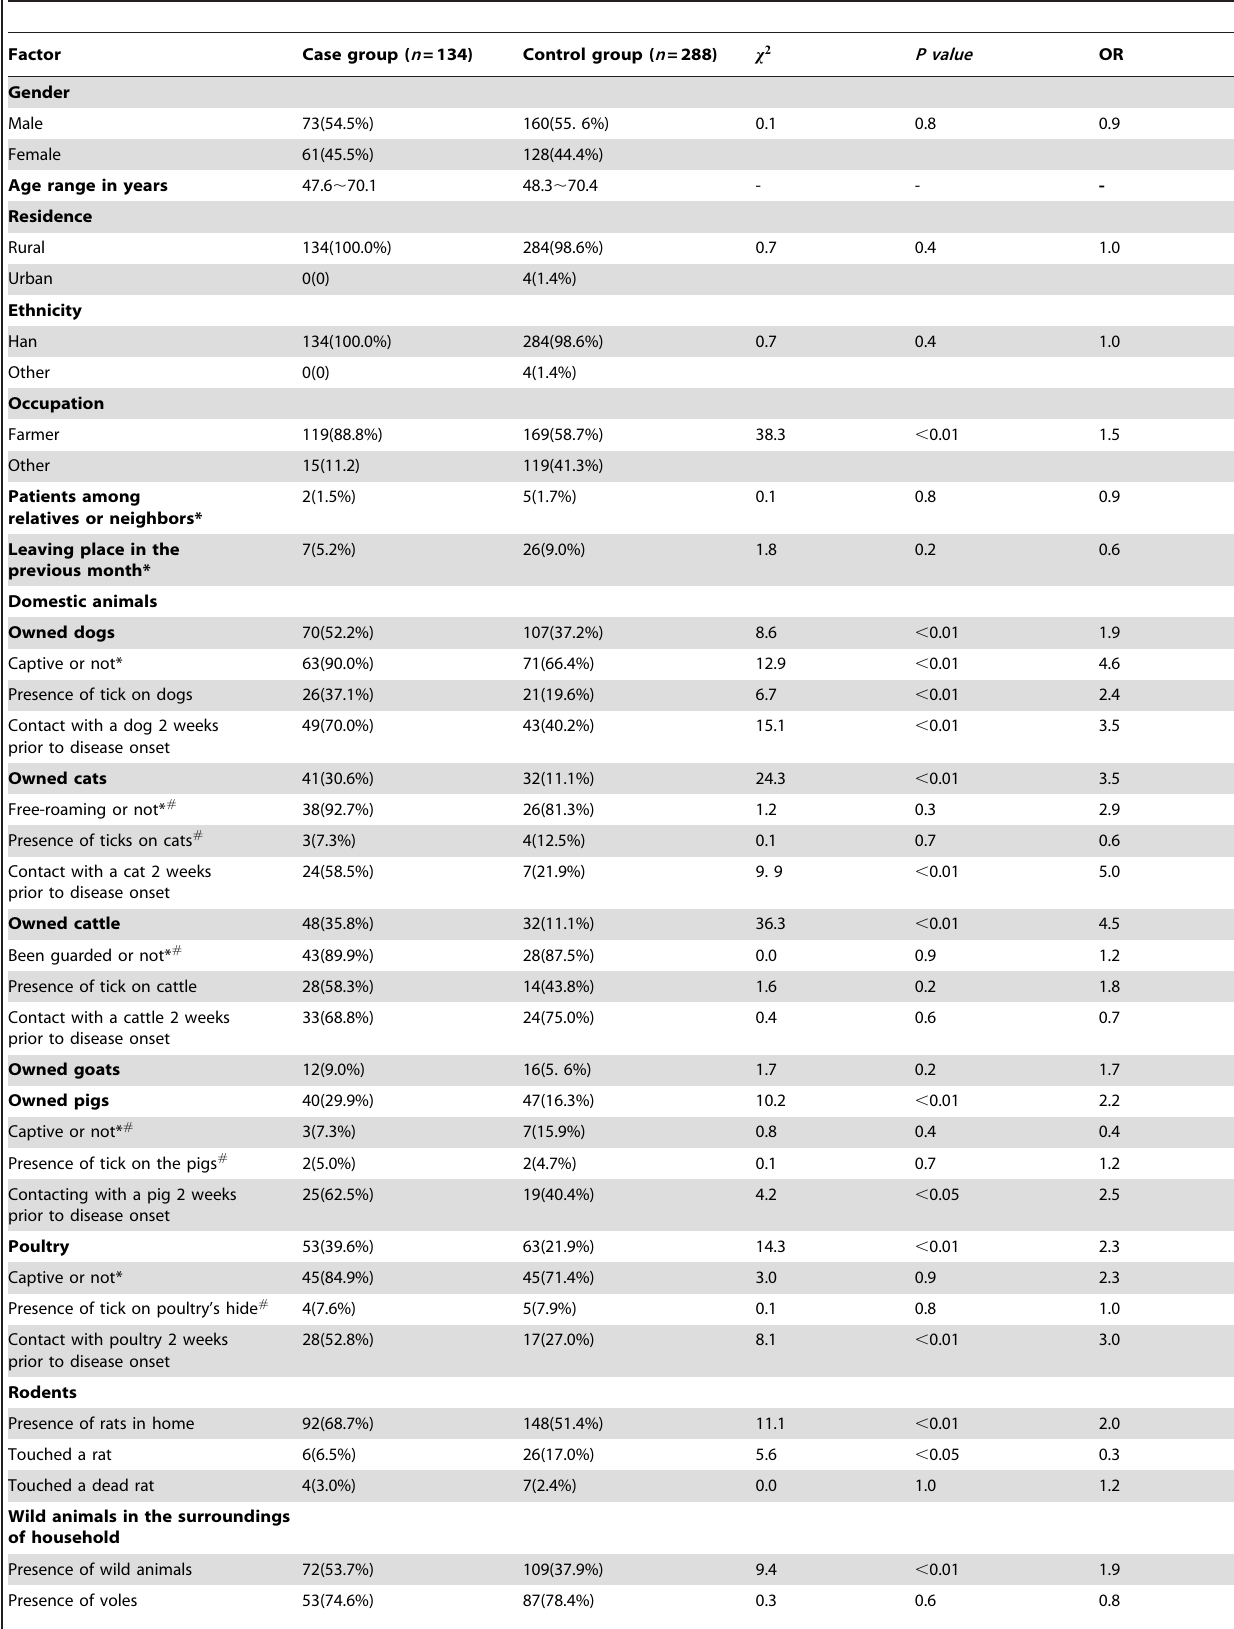
Table 3. Variables associated with SFTS, univariate analysis, central and eastern China, 2011.